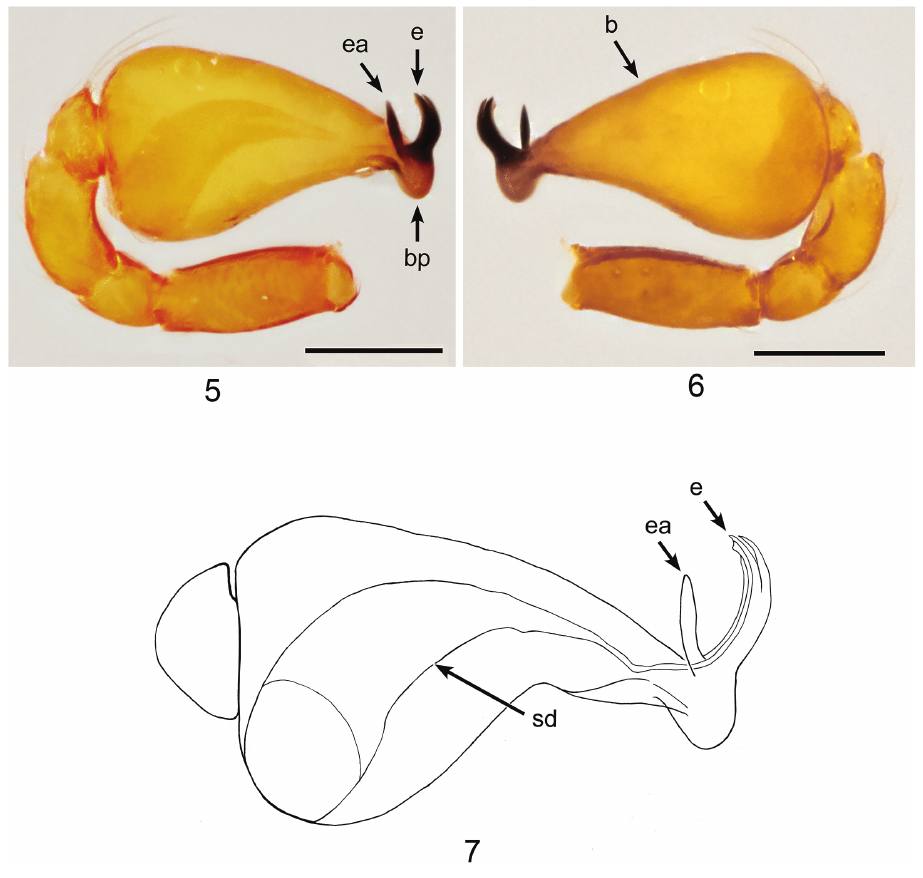
Figures 5–7. Ablemma andriana sp. n., male. 5 Palp, prolateral view. 6 Palp, retrolateral view. 7 Sche- matic illustration of palpal bulb retrolateral view. Scale bar: 0.1